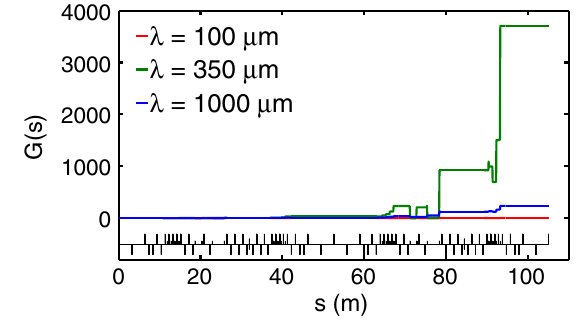
FIG. 2. CSR gain functions G ð s Þ for MEIC CCR lattice: (red)